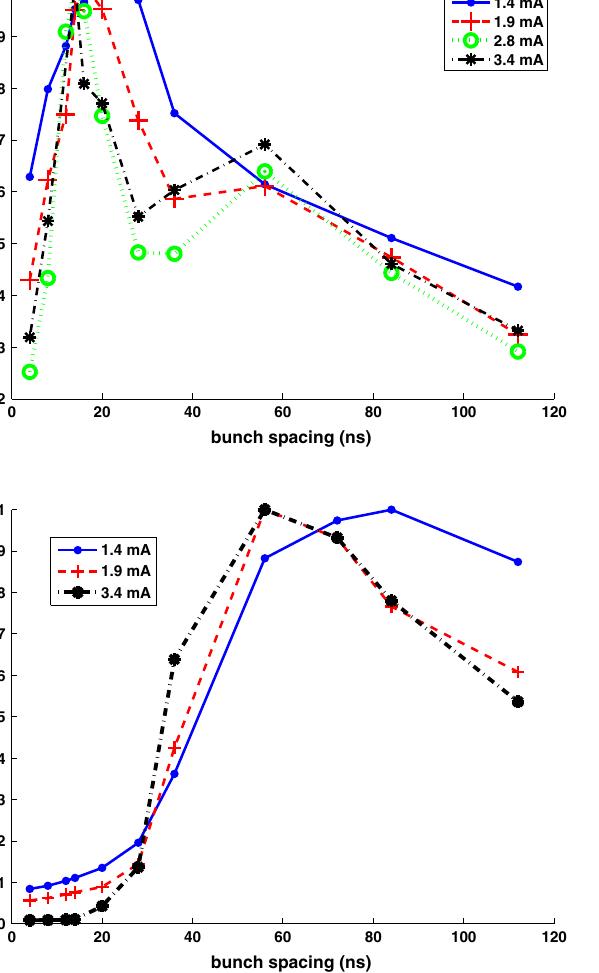
FIG. 2. Central collector signal in the chicane dipole RFA (set to 810 gauss) as a function of bunch spacing, at different bunch currents. Top: positron beam; bottom: electron beam. Note that the signals have been normalized to be on the same scale. In absolute terms, the peak positron signal was about 5 times the peak electron signal.